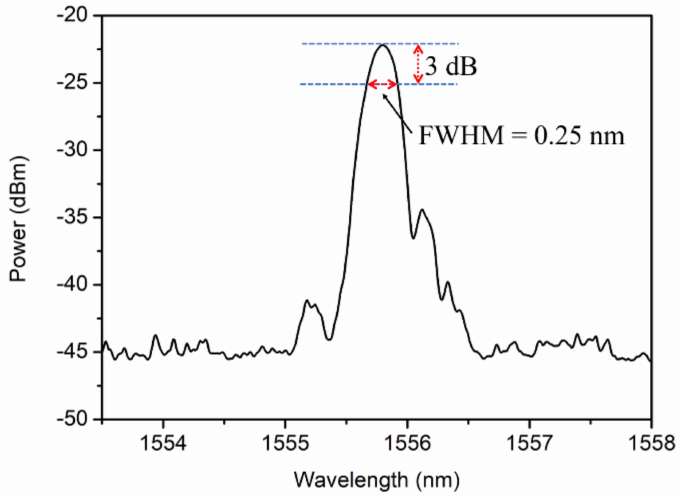
Figure 3. Reflected spectrum of the POFBG after annealing at 60 ◦ C and 90% RH for 48 h. The full width at half maximum is 0.25